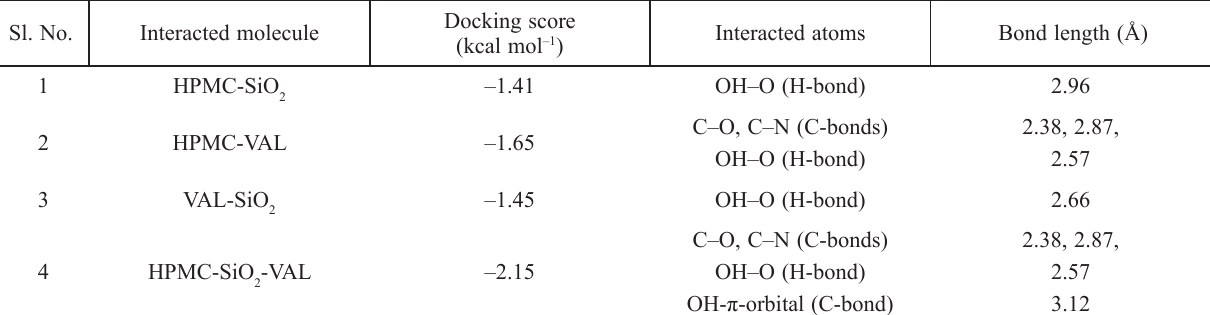
Table 4 – Molecular docking study and interaction analysis of HPMC, Aerosil, and valsartan in computational drug analysis pro- spective Sl.